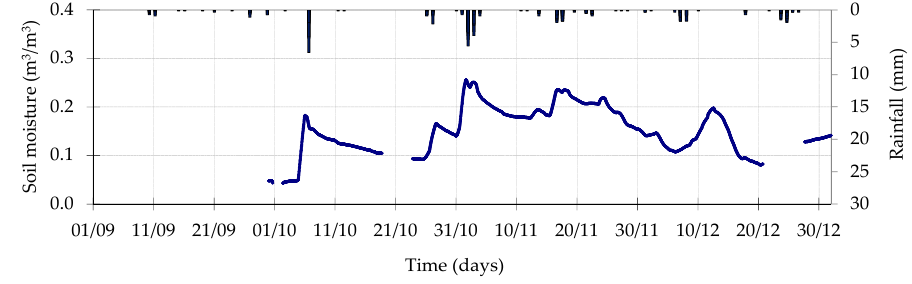
Figure 17. Cogne site, September–December 2010. Precipitation and soil moisture at 0.10 m depth.